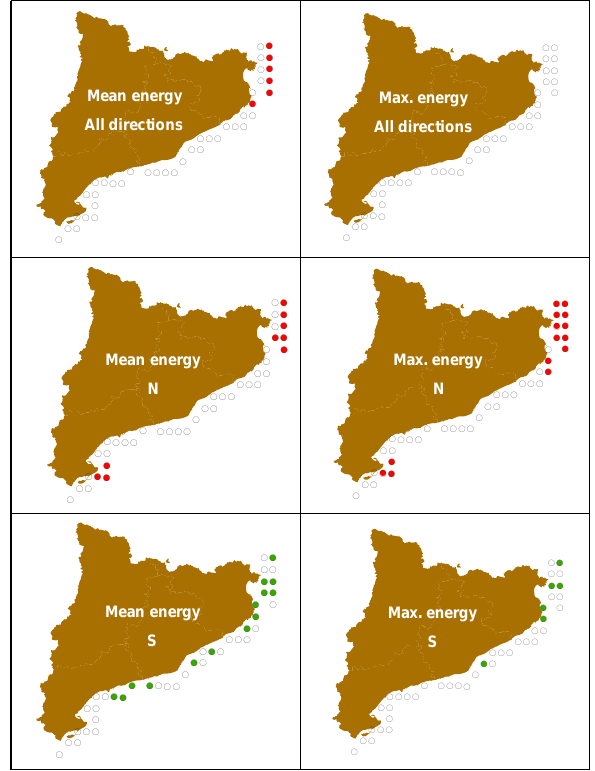
Figure 2. Trend detection of wave storminess for some directions. Red: negative trend. Blank: no significant trend. Green: positive trend.